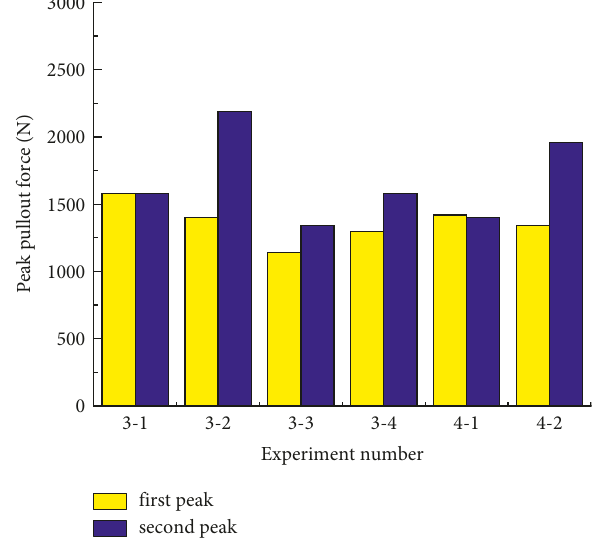
Figure 15: Comparison of peak values of sand matrix pull-out test.